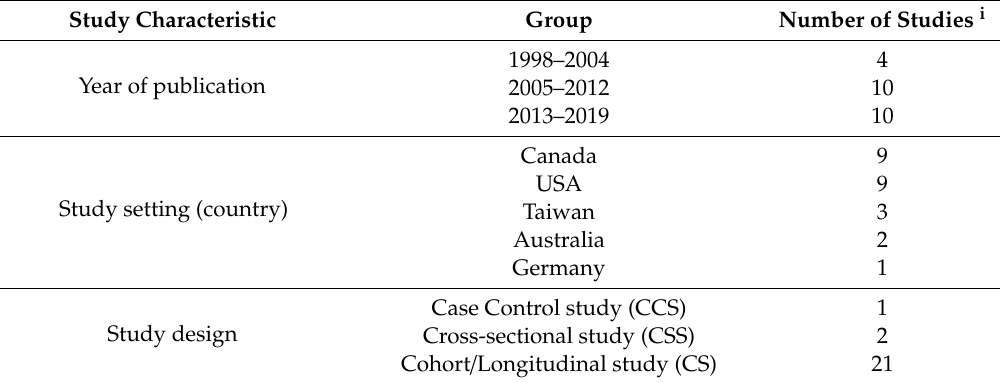
Table 1. Overview of included studies ( n =